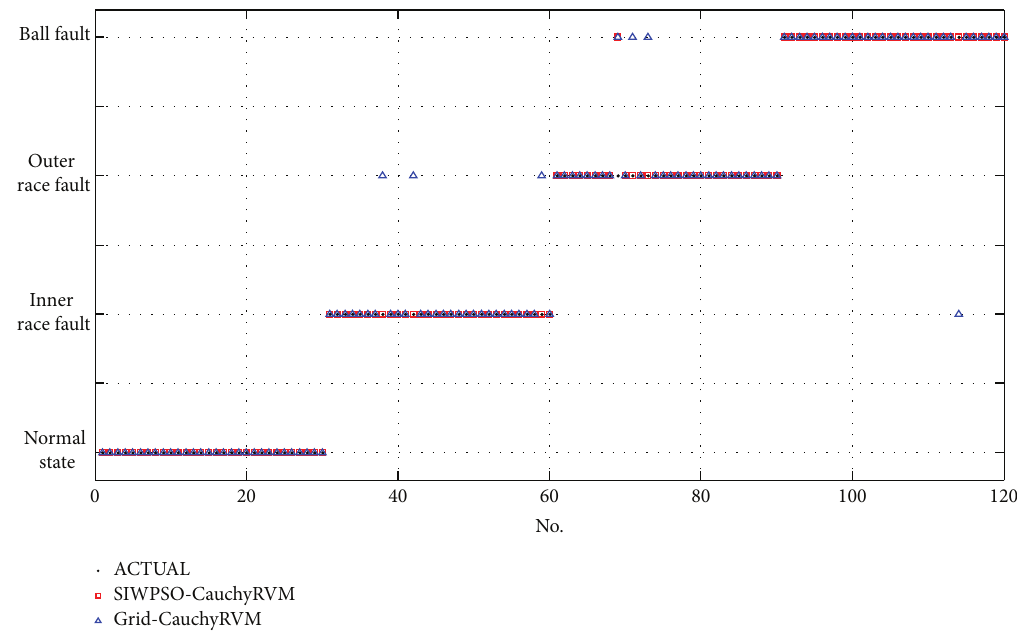
Figure 4: The comparison of the diagnosis results between SIWPSO-CauchyRVM and Grid-CauchyRVM in experiment 1.